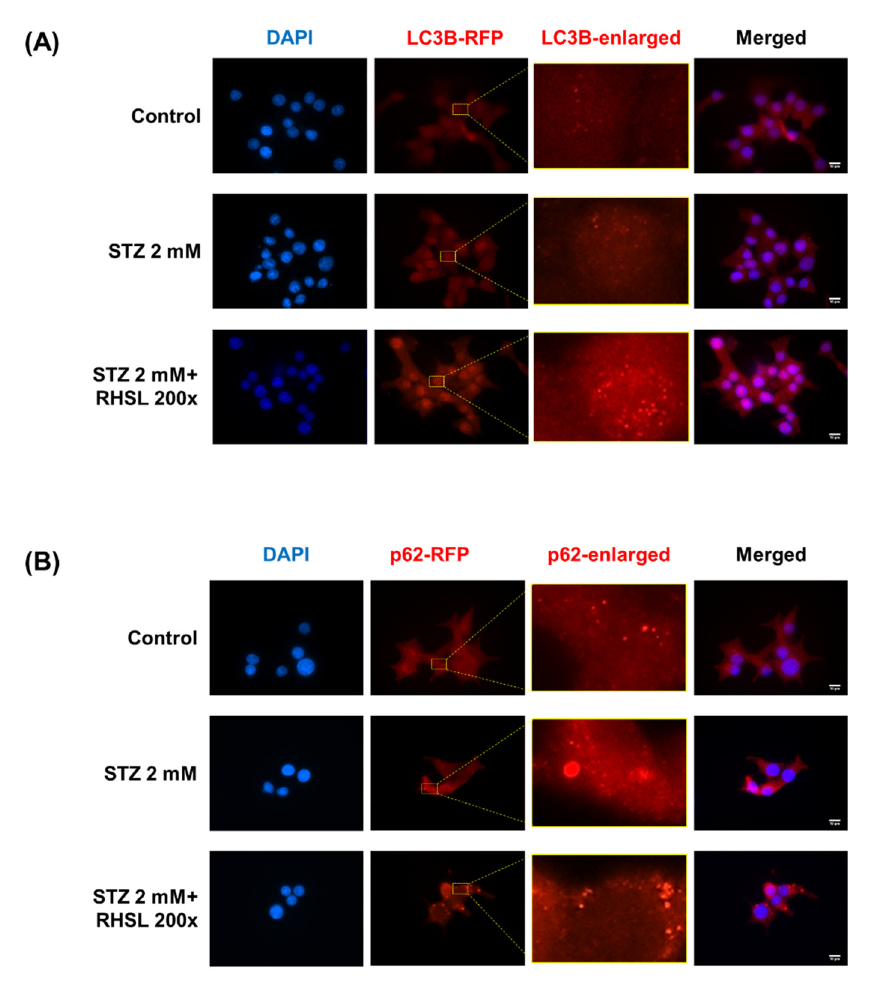
Figure 4. Effect of RHSL on STZ-induced autophagic disturbance in RIN-m5F cells. Representative microscopic images of LC3B ( A ) and p62/SQSTM1 ( B ) -immunostained RIN-m5F after STZ and RHSL treatment. Indicated rectangular areas magnified for clearer visualization of LC3 or p62/SQSTM1 puncta. Nuclear counterstaining was performed with 4’,6-Diamidino-2-phenylindole (DAPI). Calibration bar = 10 µm.